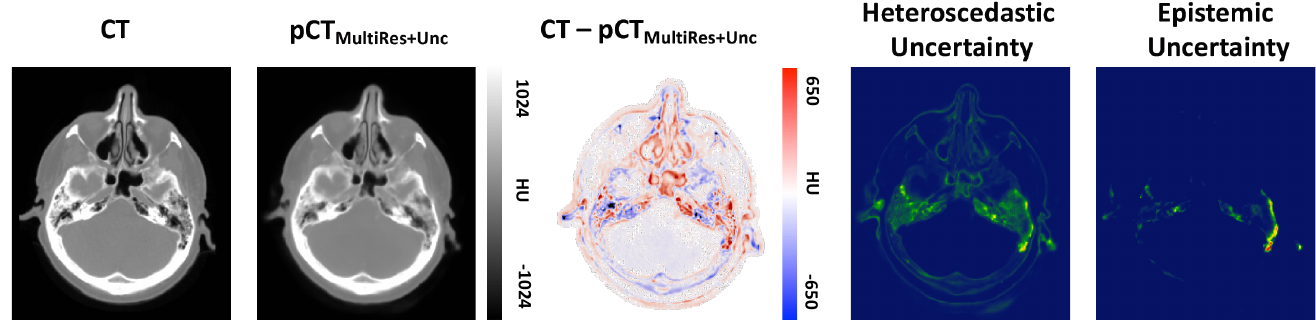
Figure 6. From left to right: Brain CT ground truth, pseudo CT prediction of MultiRes unc , corresponding residuals, heteroscedastic uncertainty and epistemic uncertainty. Both uncertainties correlate with the residual error